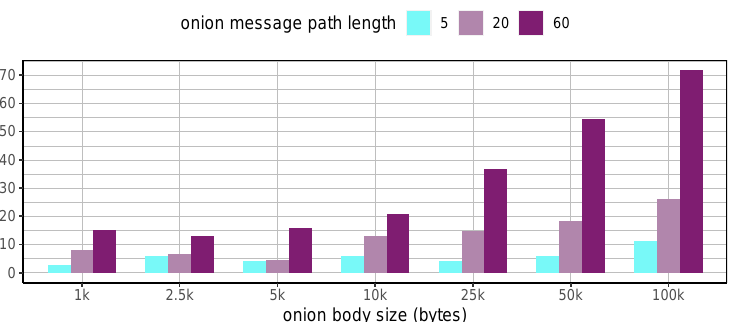
Figure 4. A plot of average ORTT of onion messages traveling through n = { 5,20,60 } nodes and having onion body size of p = {1 k, 2.5 k, 5 k, 10 k, 25 k, 50 k, 100 k} bytes. The average was computed on 30 onion